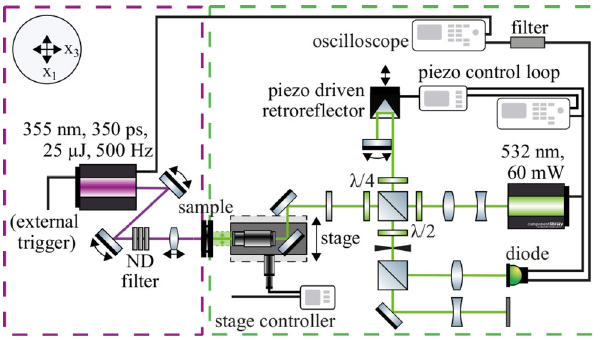
Fig. 8 Schematic view of the laser ultrasonics setup. The left side (in magenta) represents the part responsible for the laser excitation, whereas the right side (in green) displays the part used for interferometric waves detection. The Cartesian coordinate system is depicted in the upper